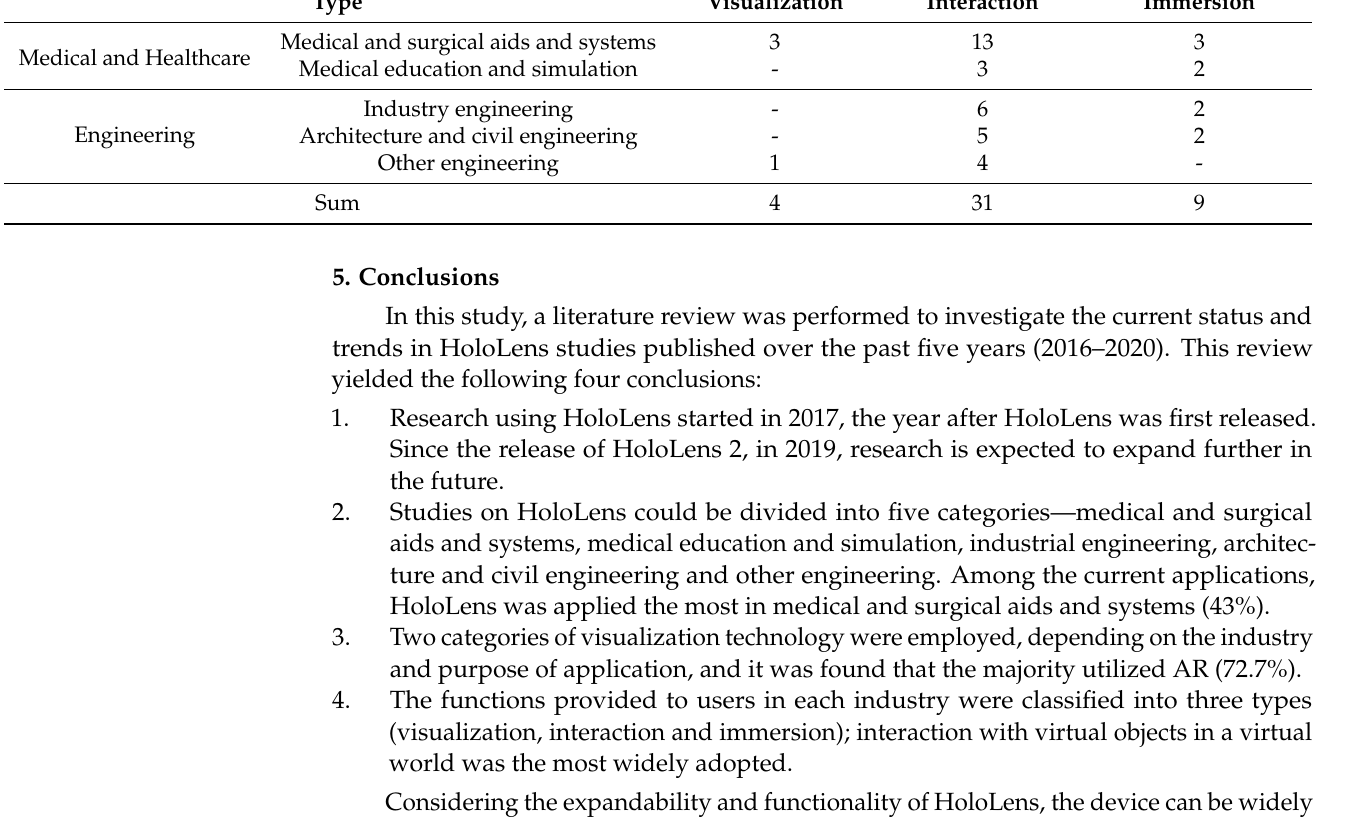
Table 8. Numbers of reviewed studies by visualization types used in the medical and healthcare and engineering fields.